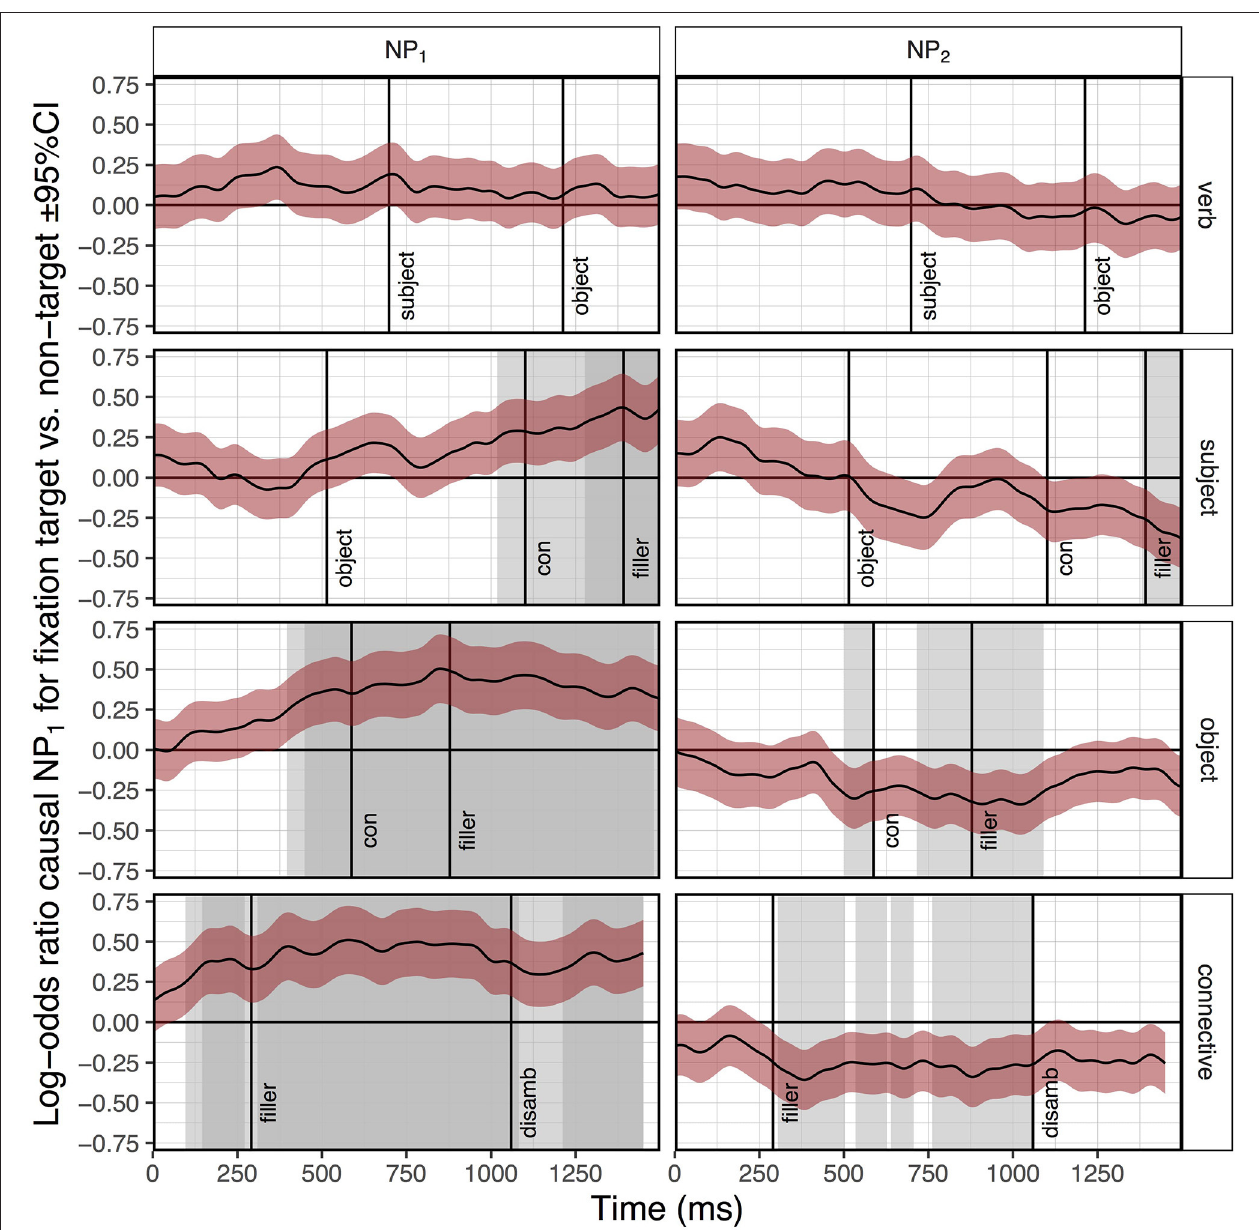
FIGURE 7 | Exploratory analysis: the log-odds of a causal vs. noncausal NP 1 argument in trials in which the target was fixated and trials in which the target was not fixated at a given millisecond. Columns show the two different targets (NP 1 and NP 2 ) and rows show the different linguistic items to the onset of which the eye-movement data were time-locked. Vertical lines indicate the mean onsets of the auditory regions. Shaded areas indicate time regions where the difference was statistically significant after false discovery rate correction (light shading: α = 0.05; dark shading: α =